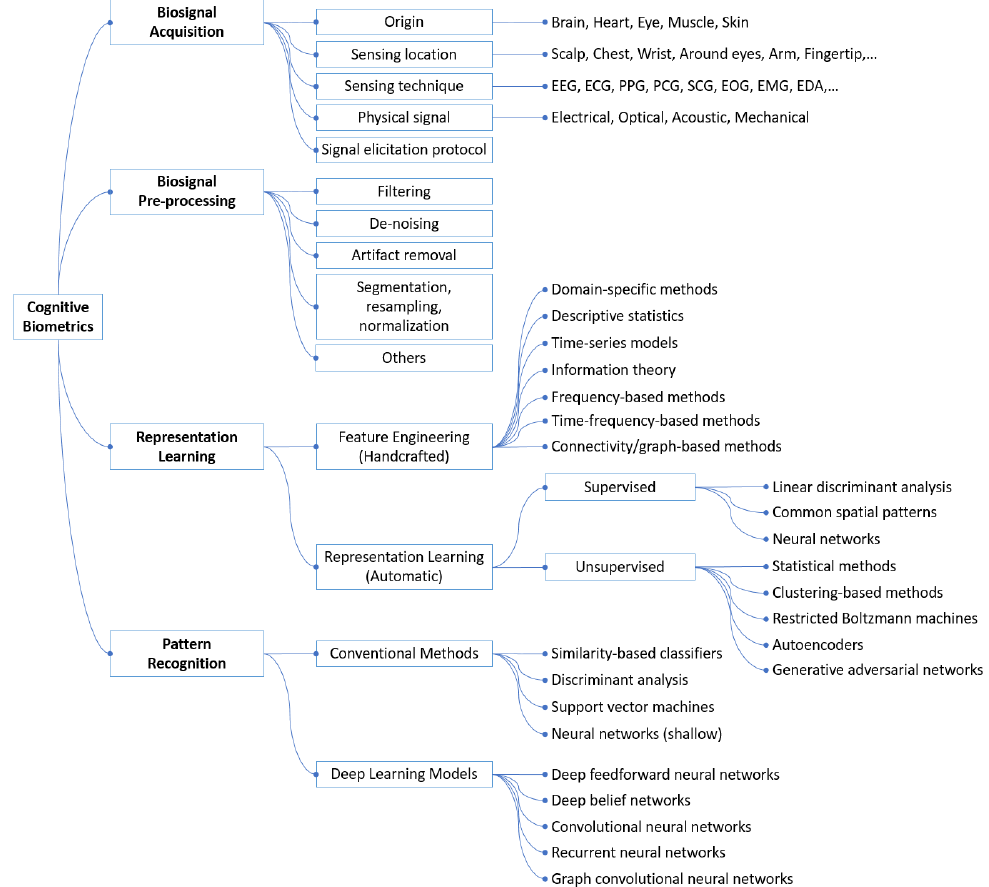
Figure 2. A taxonomy of cognitive